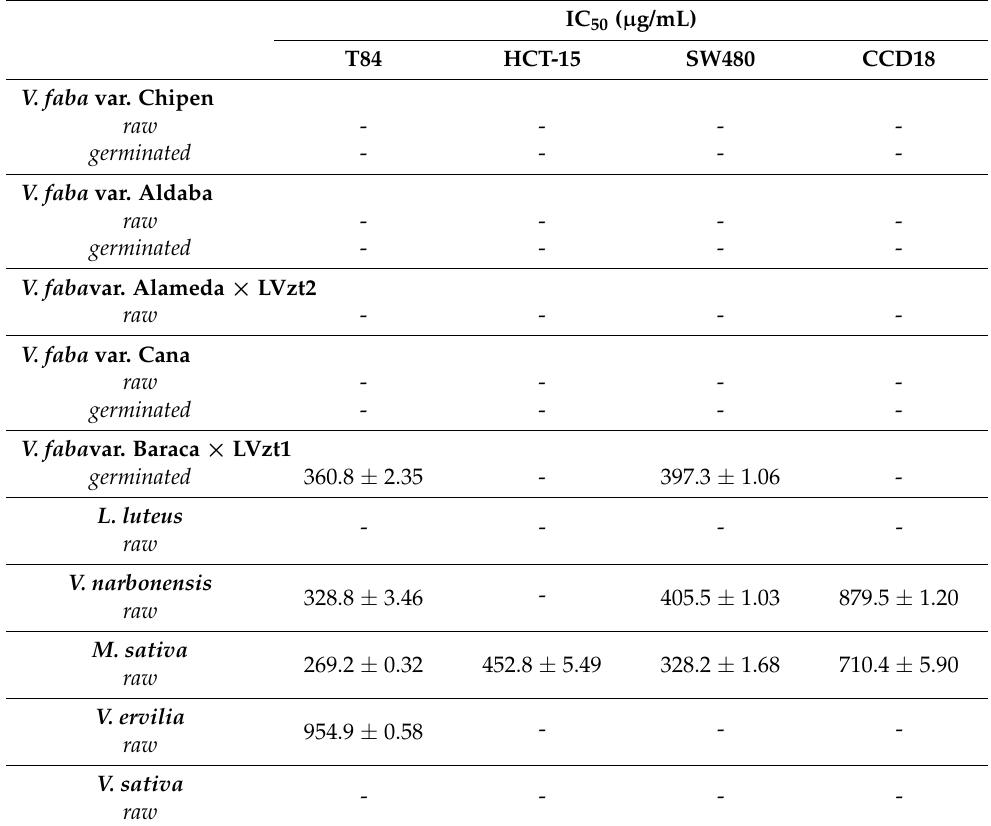
Table 6. Antiproliferative activity (IC 50 ) of the protein hydrolysates against the CRC cell